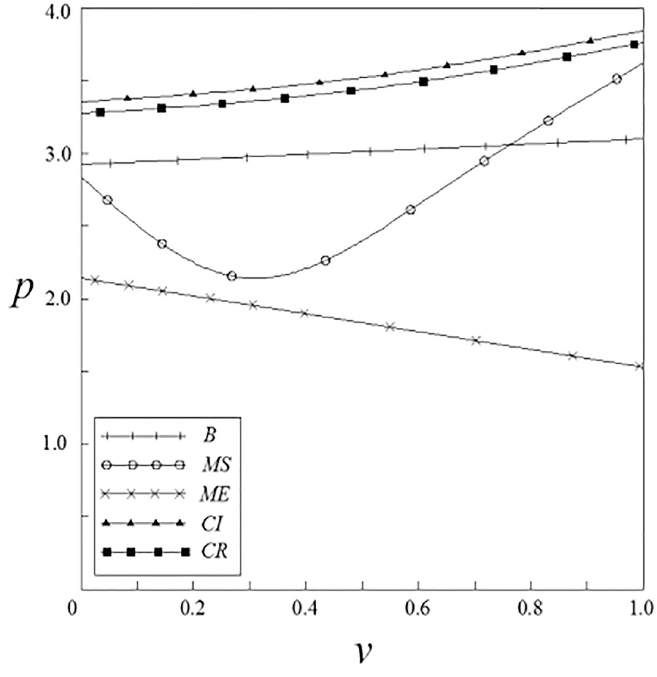
Fig 9. The relationship between p and ν .